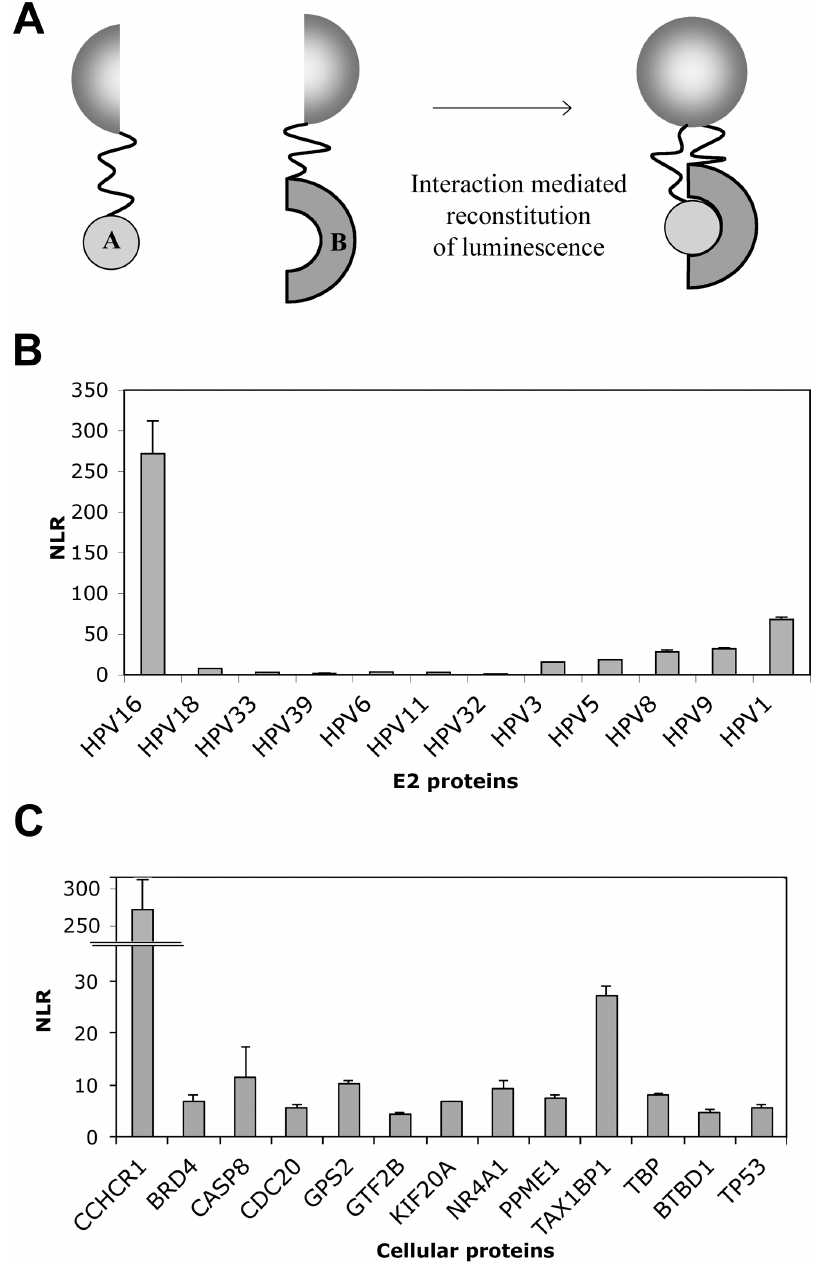
Figure 1. Interaction between HPV16 E2 and CCHCR1. (A) Schematic representation of the GPCA technique. Two proteins A and B are co- expressed in 293 T cells as fusions with two inactive and complementary fragments of the Gaussia princeps luciferase. An interaction between A and B proteins reconstitutes the Gaussia enzymatic activity by bringing in close proximity both fragments. The interaction level is estimated from a NLR (Normalized Luminescence Ratio) corresponding the Gaussia luciferase activity measured when both fusion proteins are expressed divided by the sum of background activities generated by each fusion protein expressed with the empty complementary vector (see [16] for further details). (B) CCHCR1 binding to a panel of E2 proteins. The interactions between 12 E2 proteins and CCHCR1 were measured in GPCA. **, p , 0.01 versus the interaction between HPV16 E2 and CCHCR1. (C) Interactions between HPV16 E2 and a panel of known HPV16 E2 interacting partners. The interactions between HPV16 E2 and 13 literature-curated known interactors of this E2 protein were assessed in GPCA. **, p , 0.01 versus the interaction between HPV16 E2 and CCHCR1. doi:10.1371/journal.pone.0092581.g001 comparison to the interaction between HPV16 E2 and CCHCR1. (Fig. 1C). In good agreement with the literature, all a priori positive We ascertained that the high NLR associated specifically with interactions scored an NLR above 3.5, indicative of positive HPV16E2/CCHCR1 interaction was not due to a higher amount interactions [16]. Nevertheless, they appeared globally weak in